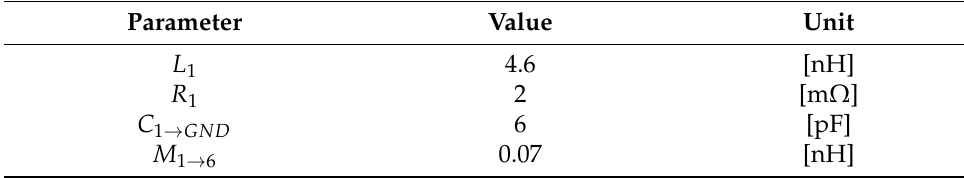
Figure 9. The equivalent circuit of the PCB with the capacitive input filter. Table 2. Parasitic values of PCB for the presented buck